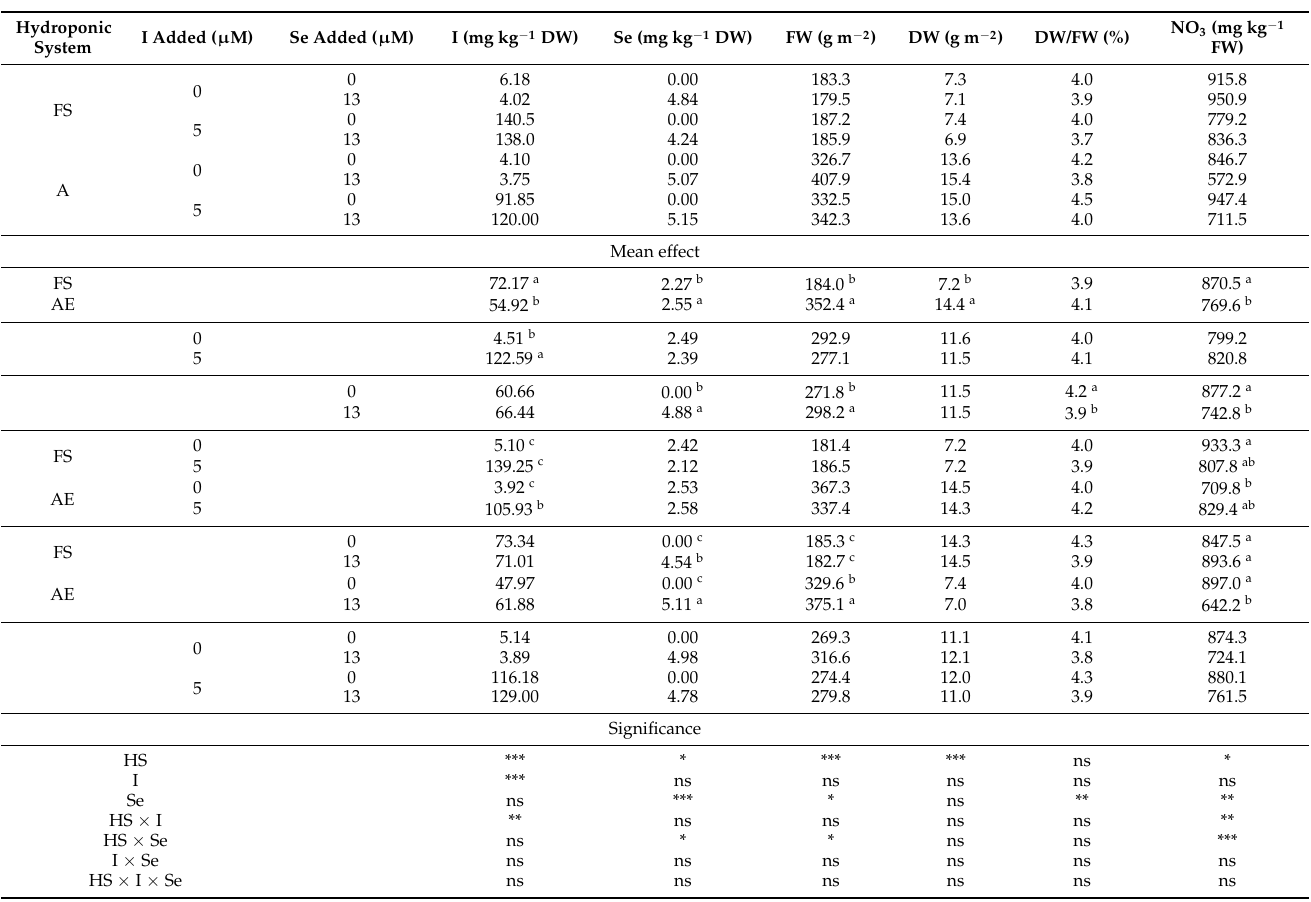
Table 2. Iodine (I) and selenium (Se) content, fresh (FW) and dry (DW) weight, dry matter percentage (DW/FW), and nitrate (NO 3 ) content in leaves of lettuce plants grown in two different hydroponic systems (HS), floating (FS) and aeroponics (AE), and at different concentrations of I and Se in the nutrient solution, in the second